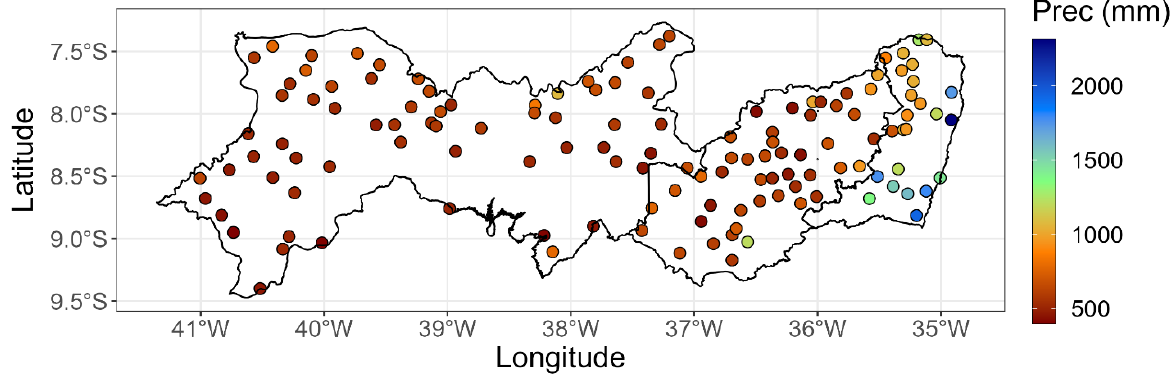
Figure 3. Mean yearly accumulated rainfall data (for the period 1962–2012) for the state of Pernambuco.